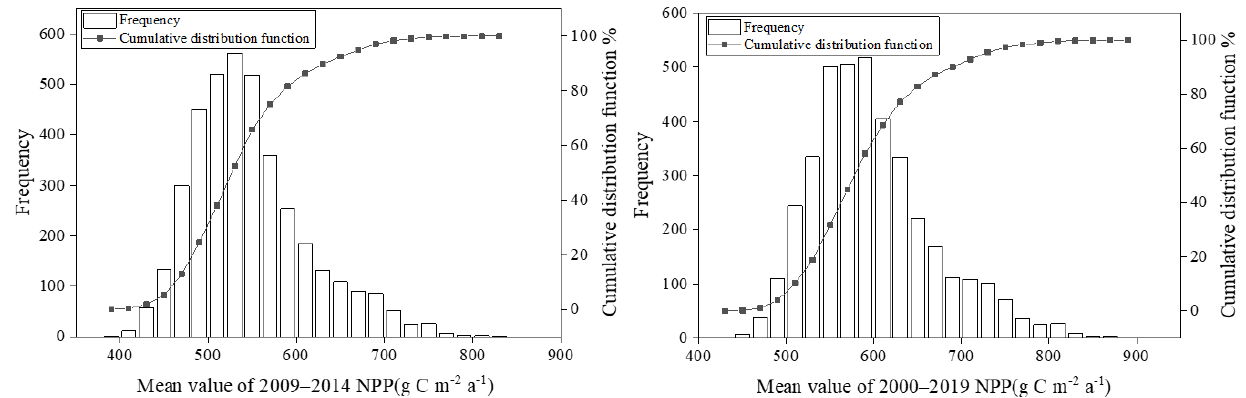
Table 5. Uncertainty analysis statistics for the different periods as determined from the EFAST global sensitivity analysis.